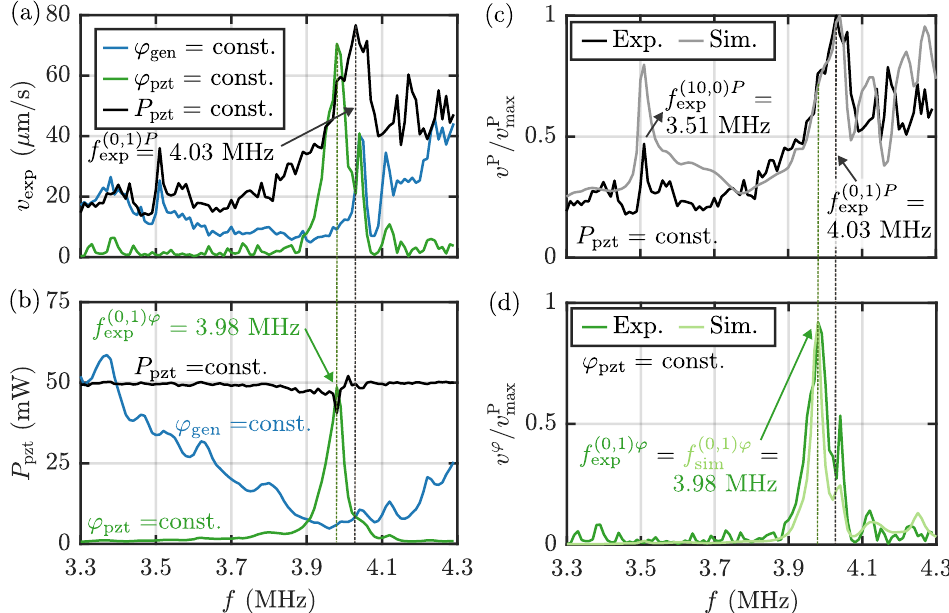
Figure 4. ( a ) Plot of the measured average acoustophoretic particle speed v exp versus frequency f in the range 3.3–4.3 MHz. ( b ) The measured power dissipation P pzt in the transducer versus f for 3.3–4.3 MHz for the three cases of constant voltage ϕ gen at the signal generator, constant voltage ϕ pzt across the piezoelectric transducer, and constant average power dissipation P pzt . ( c ) The experimental (black) and simulated (gray) normalized average particle speed v P / v P max versus frequency f at constant-power dissipation P pzt = 50 mW. ( d ) The experimental (dark-green) and simulated (light- green) normalized average particle speed v ϕ / v P max versus frequency f at constant transducer voltage ϕ pzt = 0.5